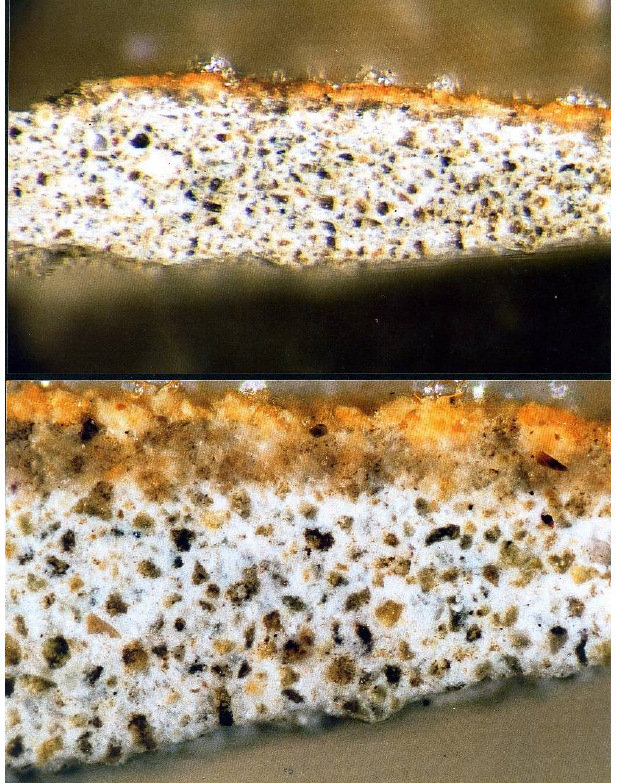
Figure 15. Centennial Hall before renovation in 2009; stratigraphies showing a yellowish outer layer (photo R. Wójtowicz).